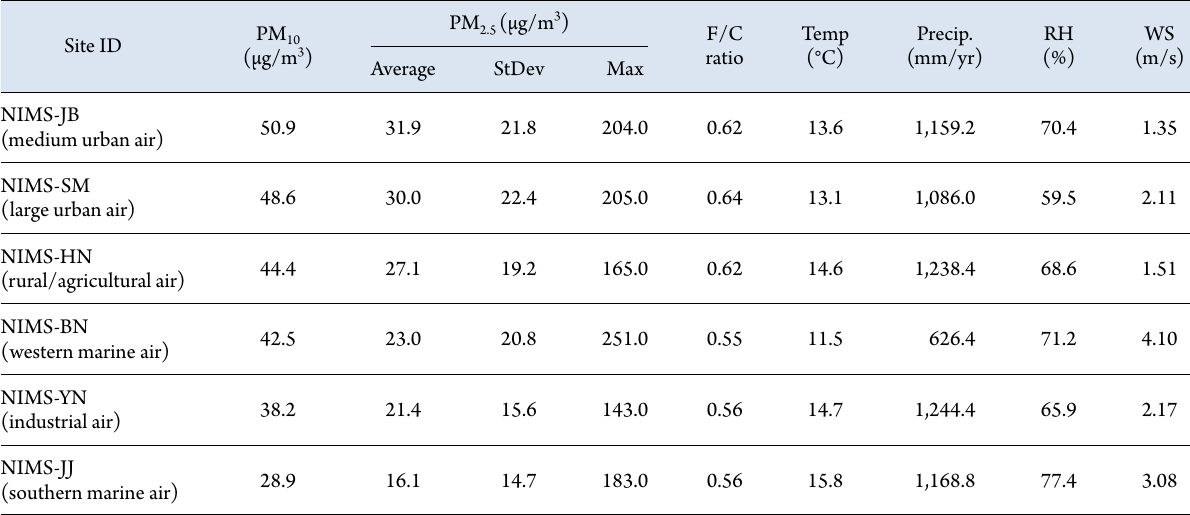
Table 3. A summary of statistics for 6-year averages of PM, F/C ratio, and meteorological parameters (Study-1). Site